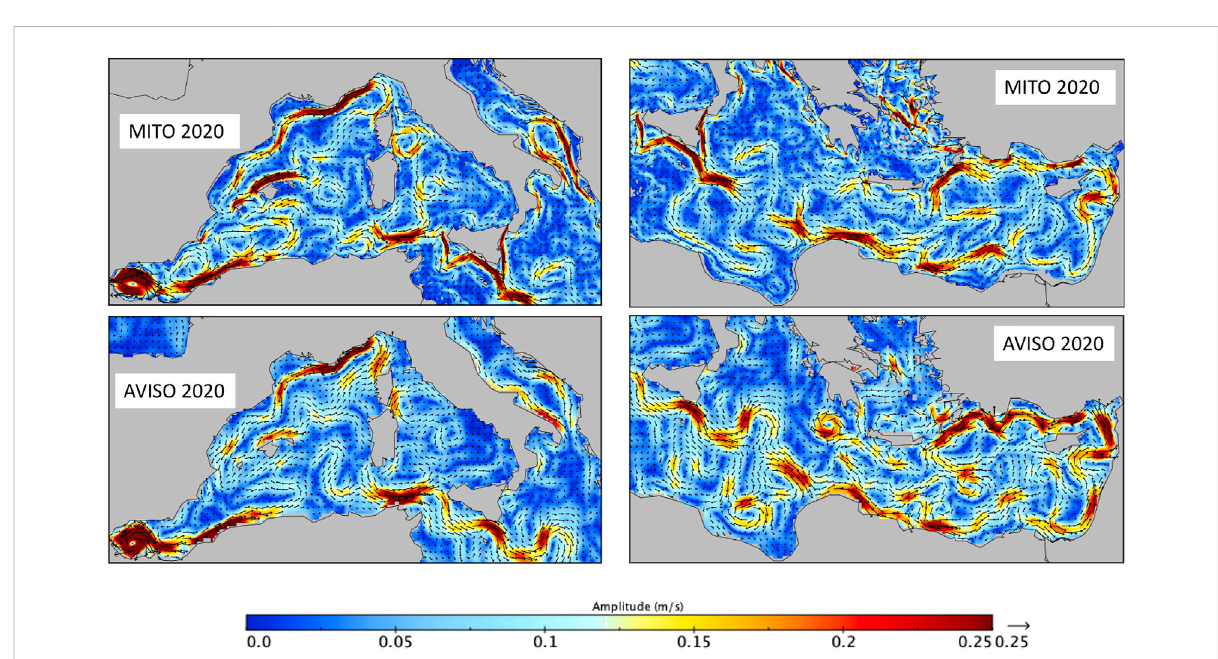
FIGURE 6 Average 2020 circulation in the western and central Mediterranean. MITO circulation at 30 m of depth in the left panels; geostrophic reconstruction from altimeter data (AVISO) in the right